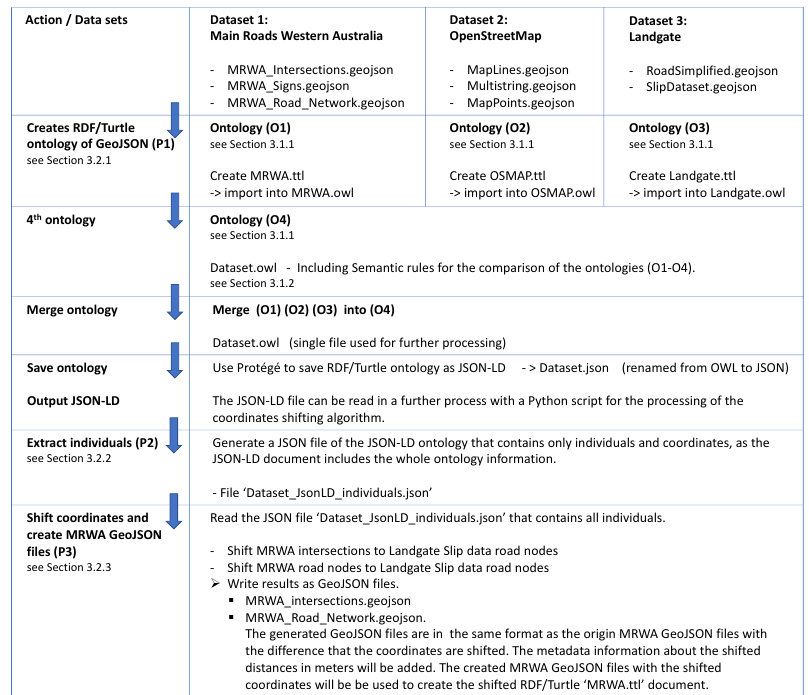
Figure 1. Workflow overview of the approach of this paper.